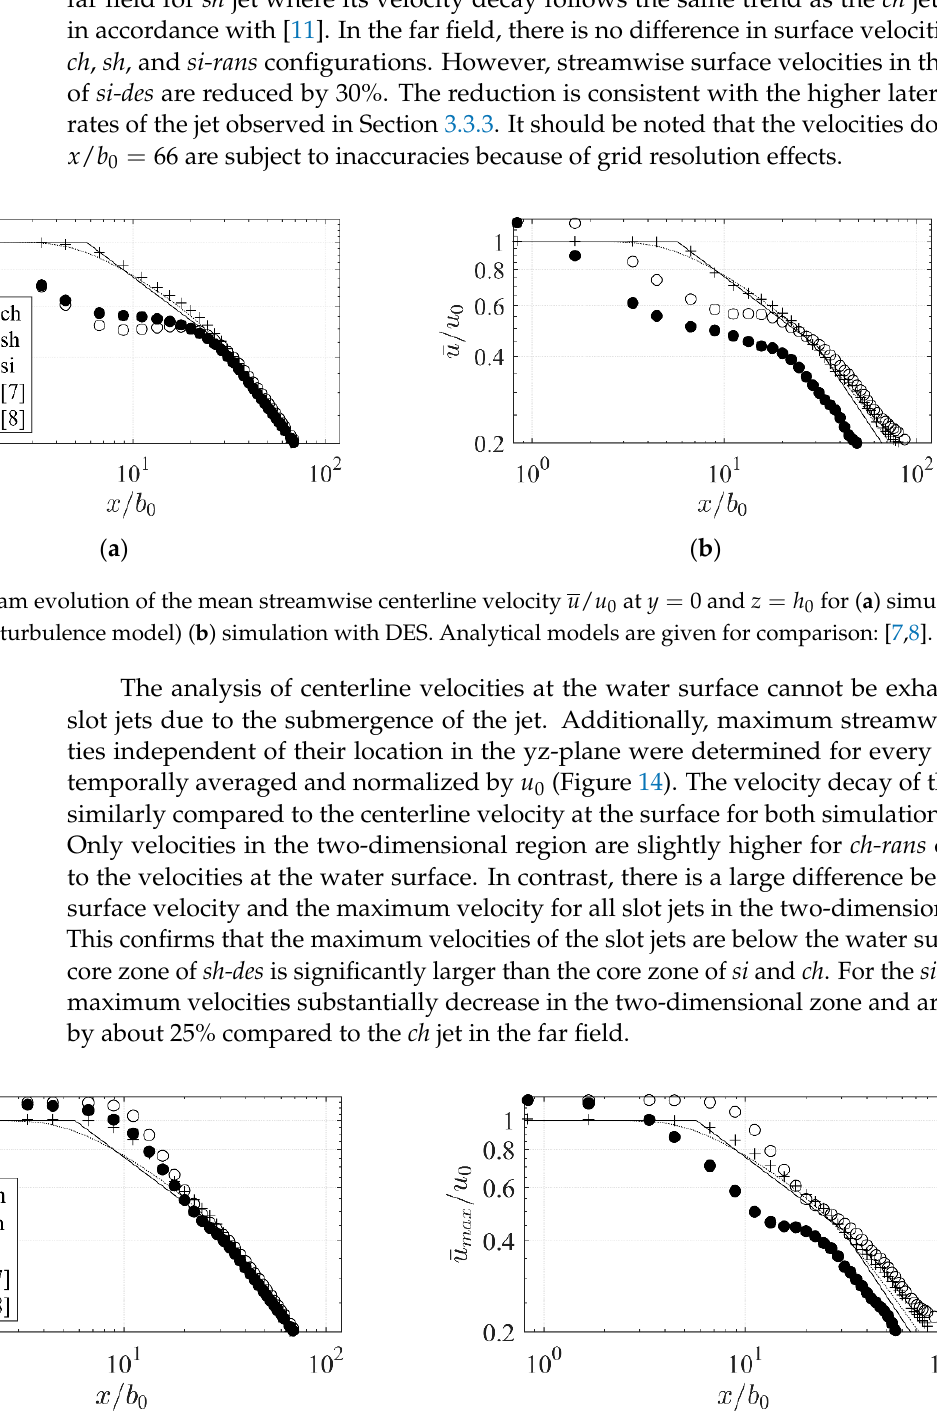
Figure 14. Downstream evolution of the mean maximum streamwise velocity 𝑢(cid:3364) (cid:3040)(cid:3028)(cid:3051) /𝑢 (cid:2868) in yz-planes in distances from the orifice; ( a ) simulation with RANS (kw-SST turbulence model); and ( b ) simulation with DES. Analytical models are given for comparison: [7,8].